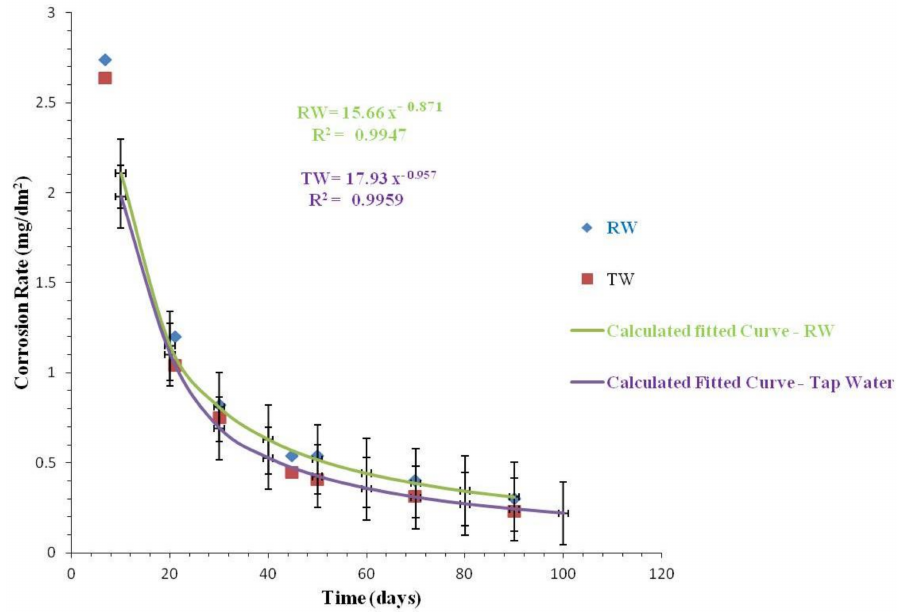
Figure 17. Corrosion rate of galvanized steel pipe coupons with RW and TW over time with standard error